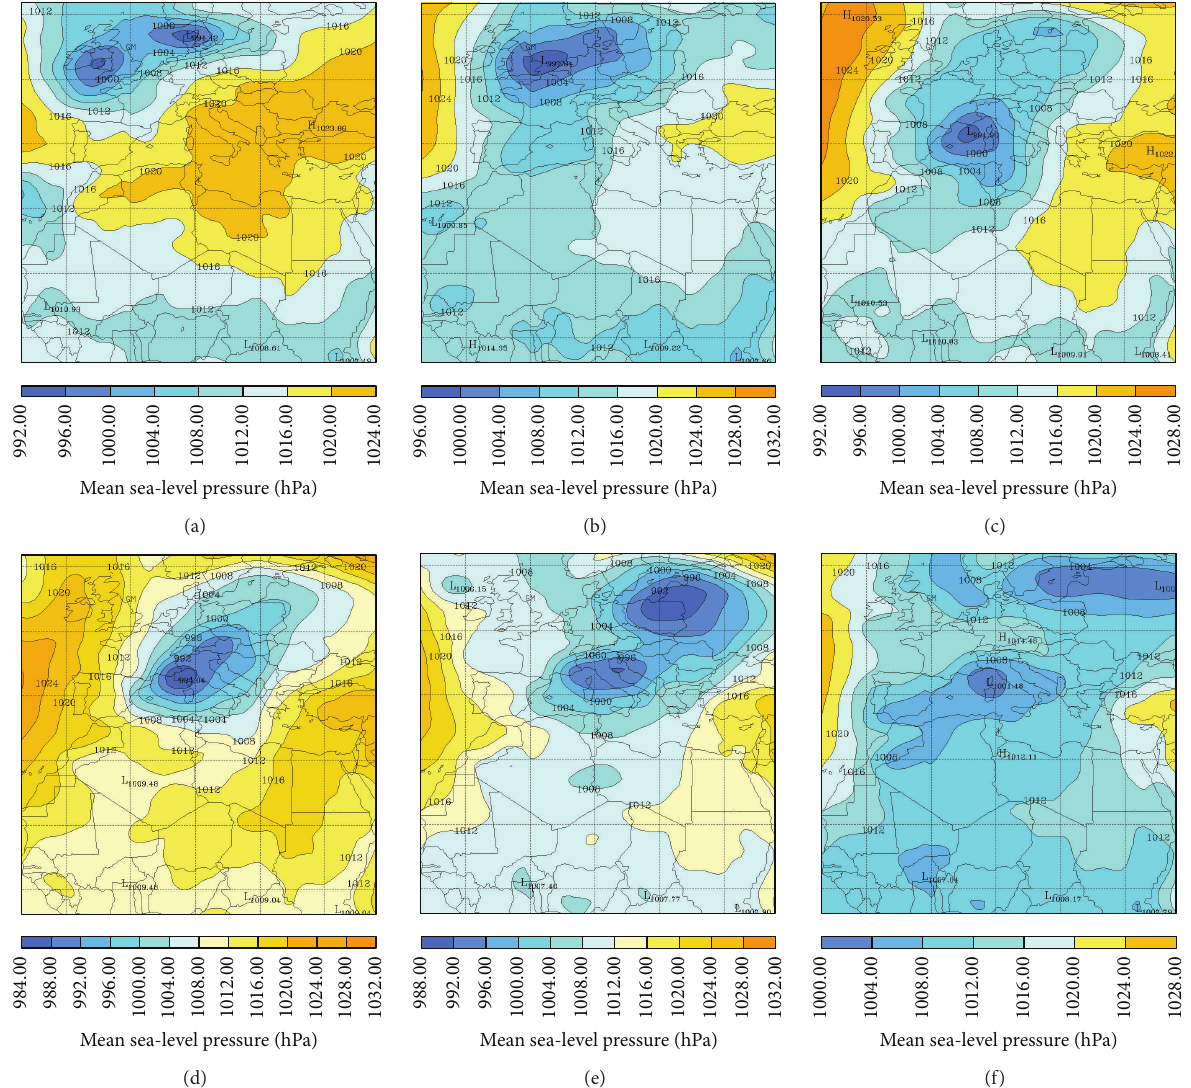
Figure 9: Surface synoptic maps over Sfax on (a) 26/11/2012, (b) 27/11/2012, (c) 28/11/2012, (d) 29/11/2012, (e) 30/11/2012, and (f)